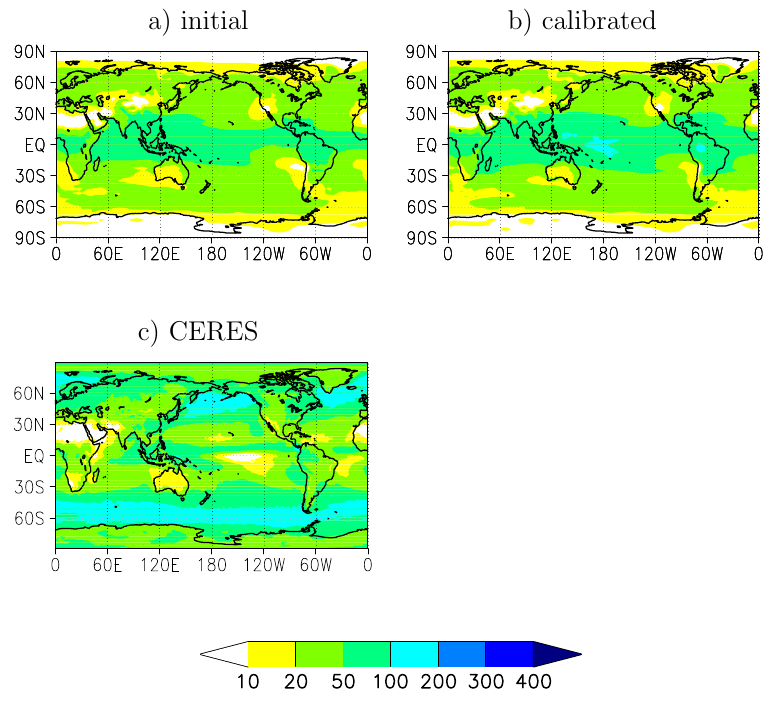
Fig. 7. Annual mean modelled total cloud water path (g ( H 2 O ) m − 2 ) for initial and calibrated parameter sets ( a and b , respectively) in comparison to the CERES climatology (c) .